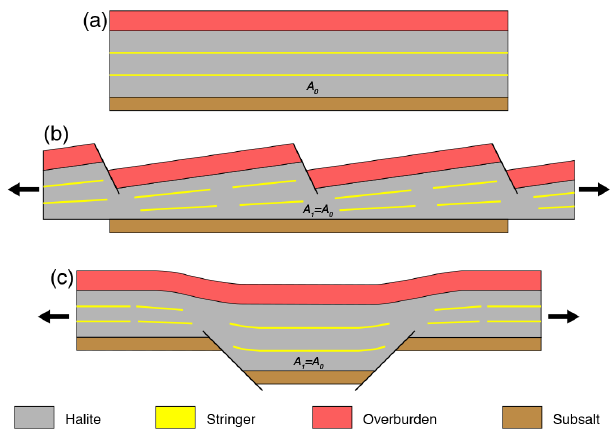
Figure 4. Conceptual diagrams of layer-parallel extension: (a) un- deformed salt layer (of area A 0 ) with two competent internal beds (yellow); (b) boudinage of competent beds into stringers during thin-skinned extension, assuming the primary décollement is near the base of salt; (c) boudinage during thick-skinned extension, con- centrated in areas of drape folds over pre-salt